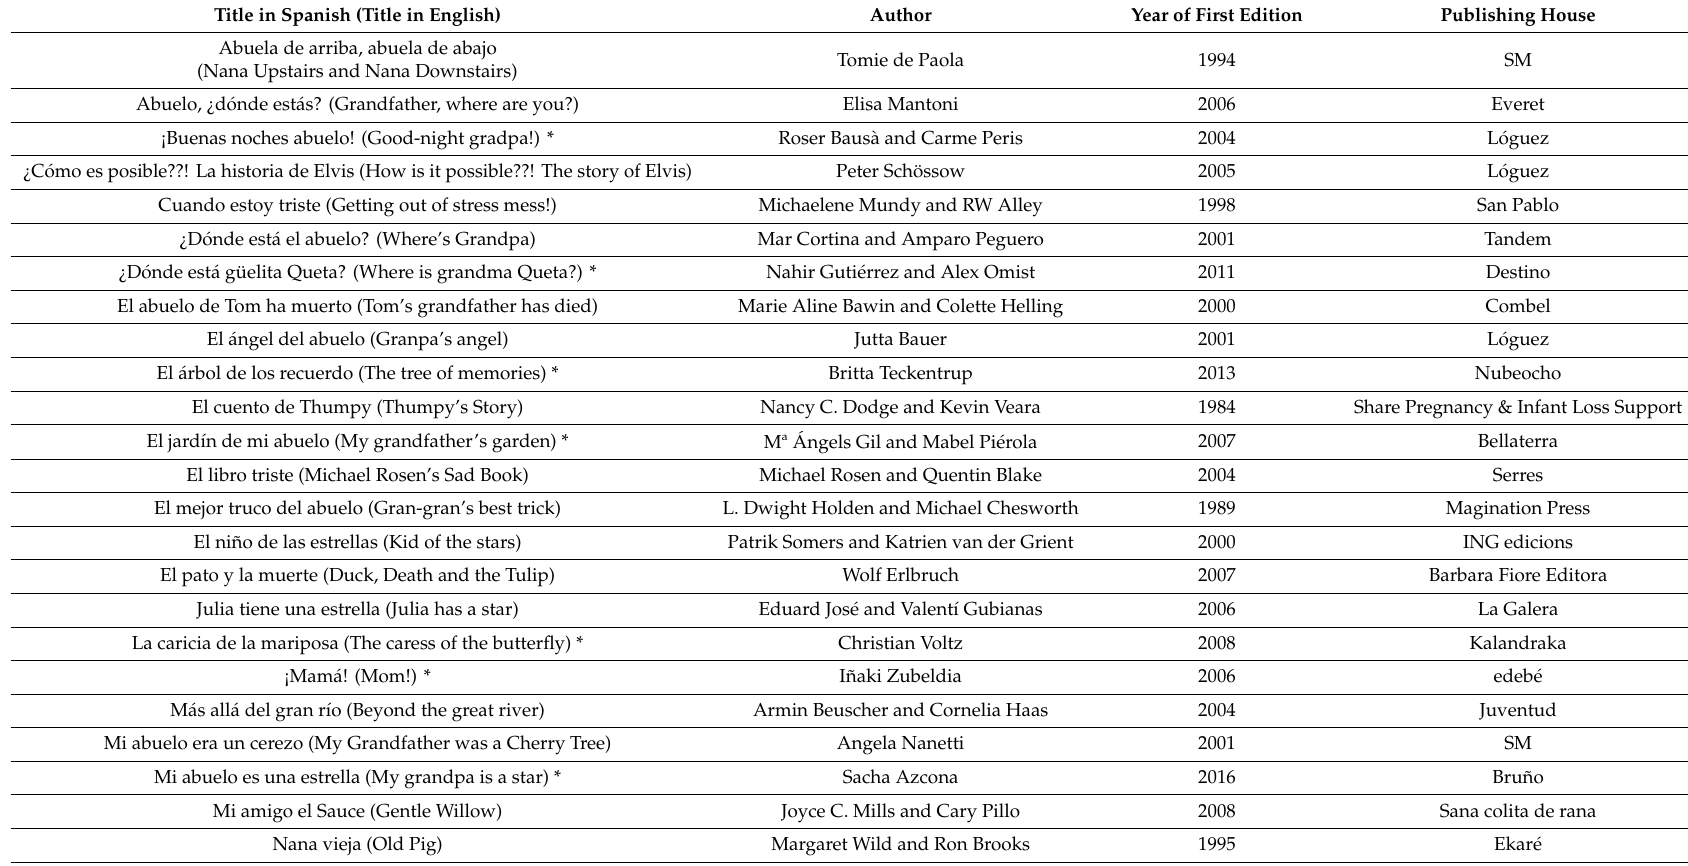
Table A1. List of selected Tales. Published in Spanish, in paper format,